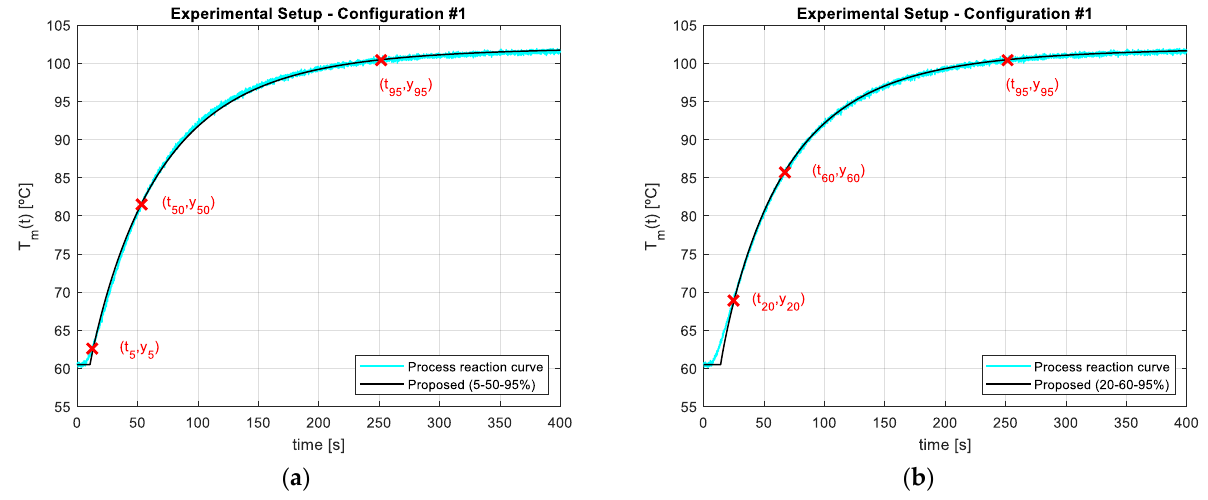
Figure 10. Process reaction curve in a certain operating point (Configuration #1) and FFOPDT model step response using the identification method proposed in [42] for the experimental setup: ( a ) Symmetrical set of points (5–50–95%); ( b ) Asymmetrical set of points (20–60–95%).